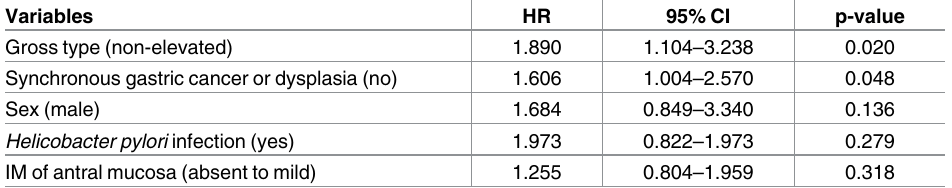
Table 3. Multivariate analysis of risk factors for early occurrence of MGT after endoscopic resection of